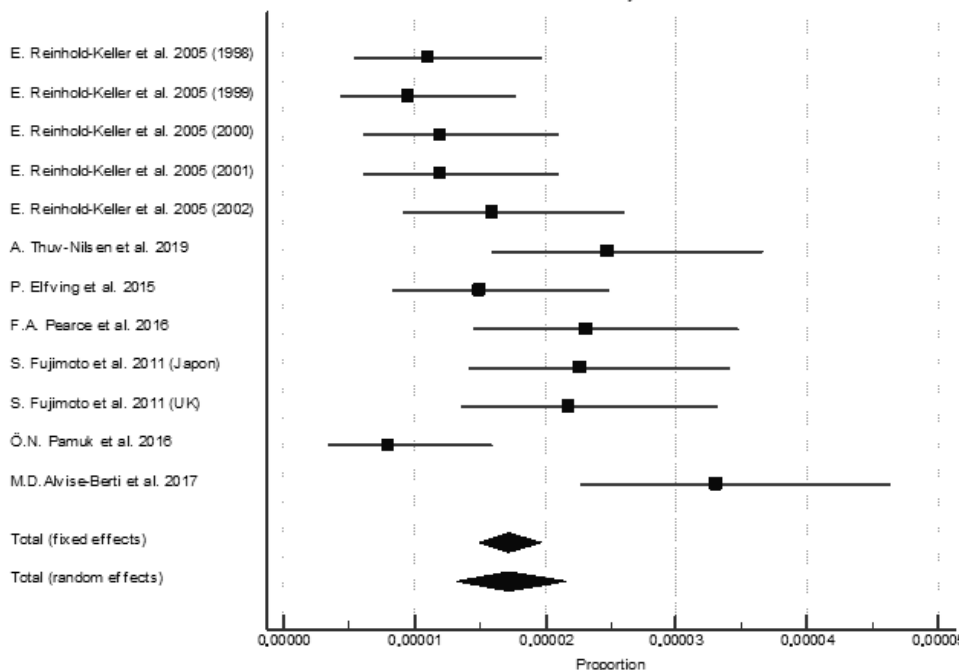
Figure 3. Pooled incidence of total ANCA-associated vasculitis [11,12,16,18,20,25,27]. Table 2. Pooled incidence of ANCA-associated vasculitis (number of studies included, 95% CI, and I 2 [heterogeneity]). Disease No. of Studies